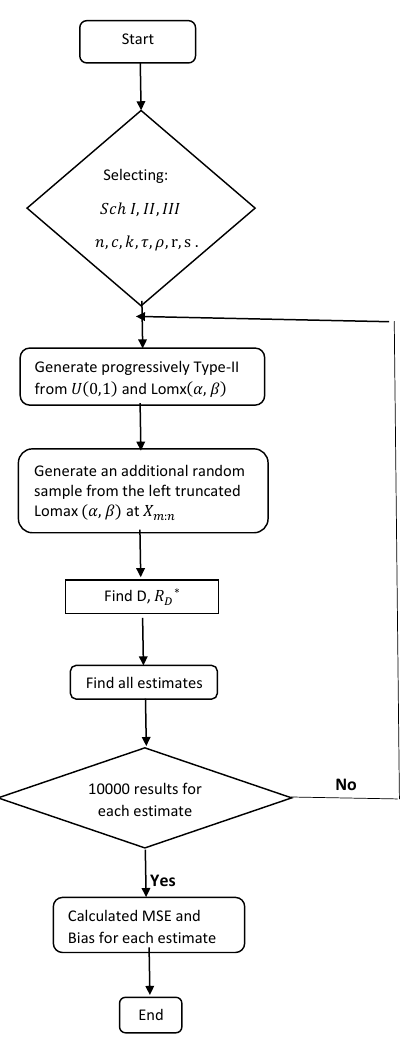
Figure 1. The flowchart for using the proposed E-Bayesian estimation methods in Section